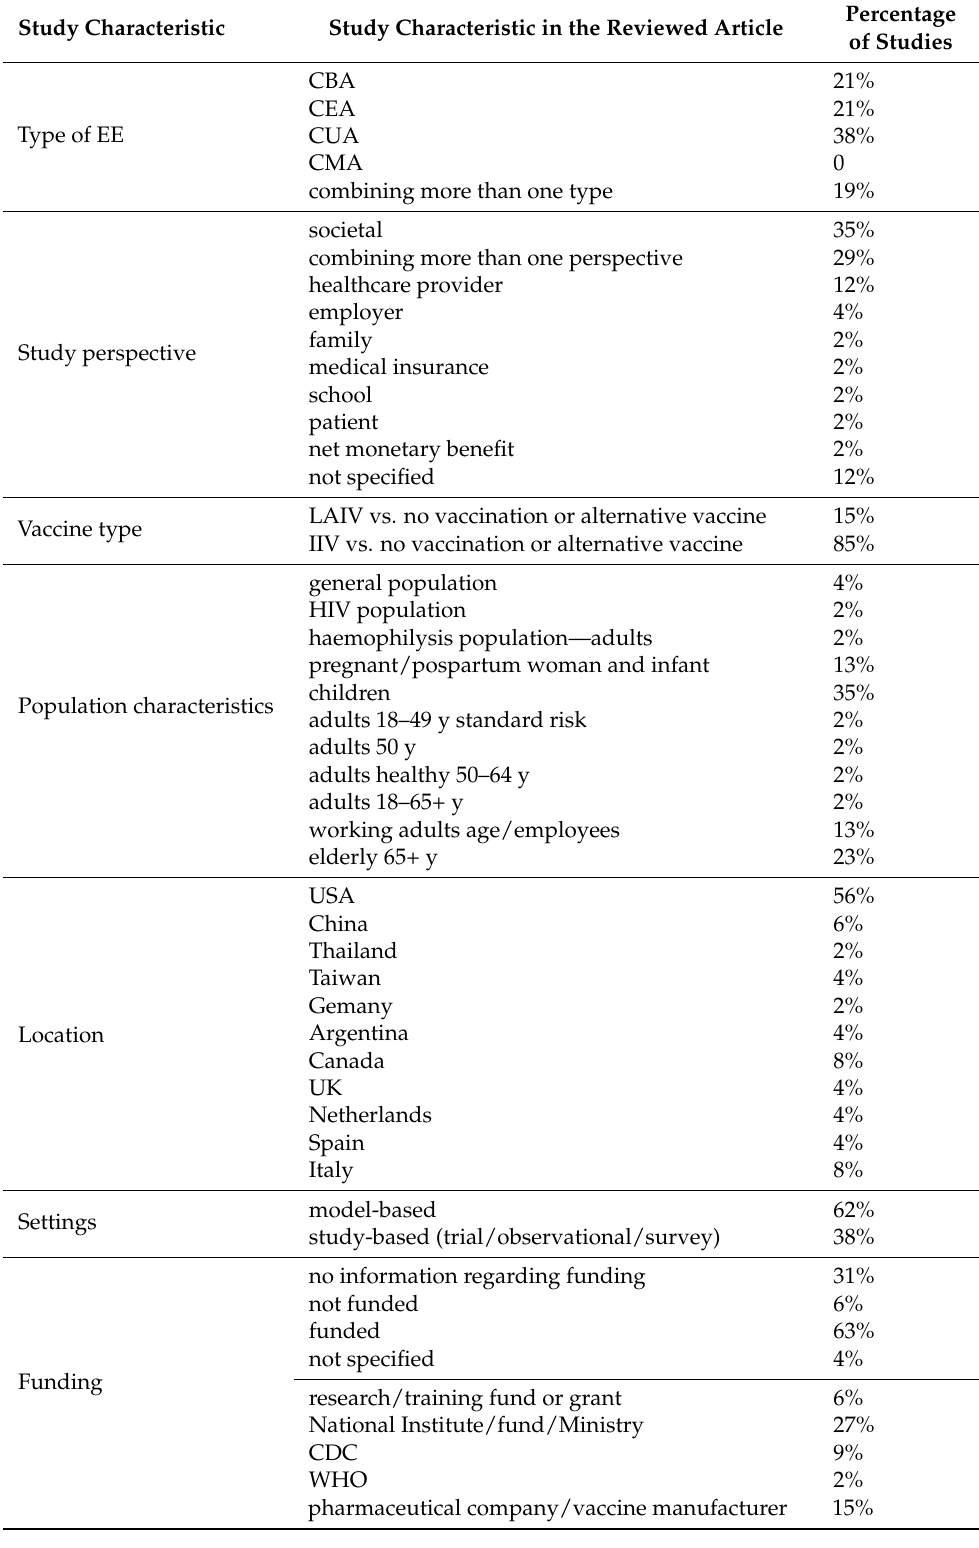
Table 2. Summary of study characteristic results from the 52 evaluated